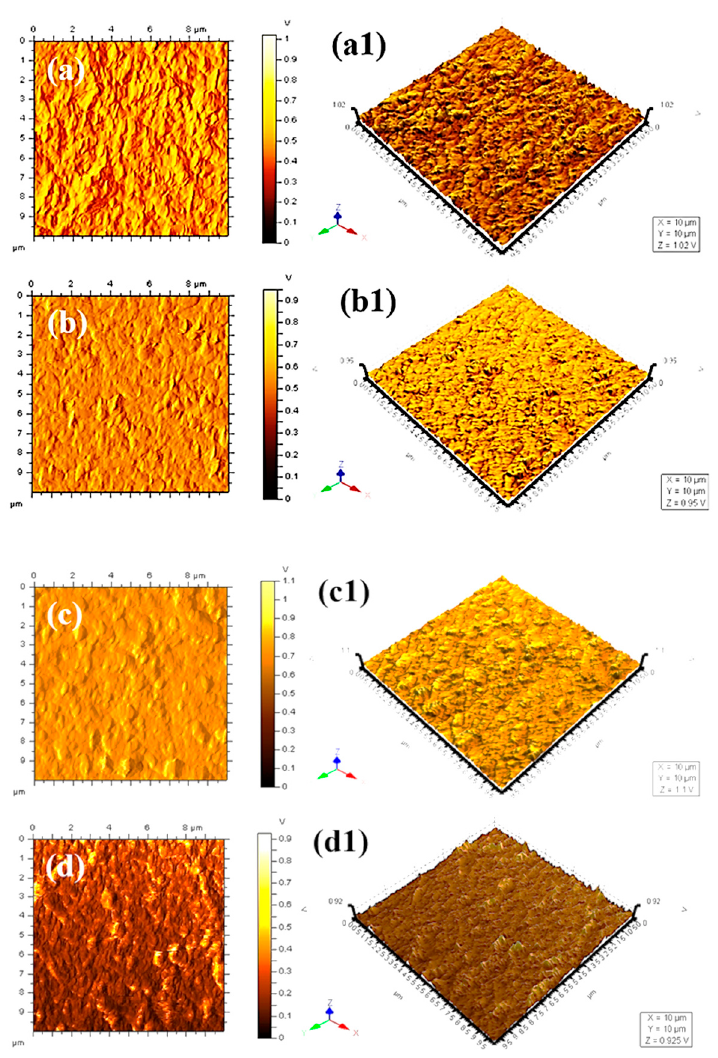
Figure 5. Three-dimensional AFM images for the membranes ( a , a1 ) M-0, ( b , b1 ) M-10, ( c , c1 ) M-20, and ( d , d1 ) M-30.